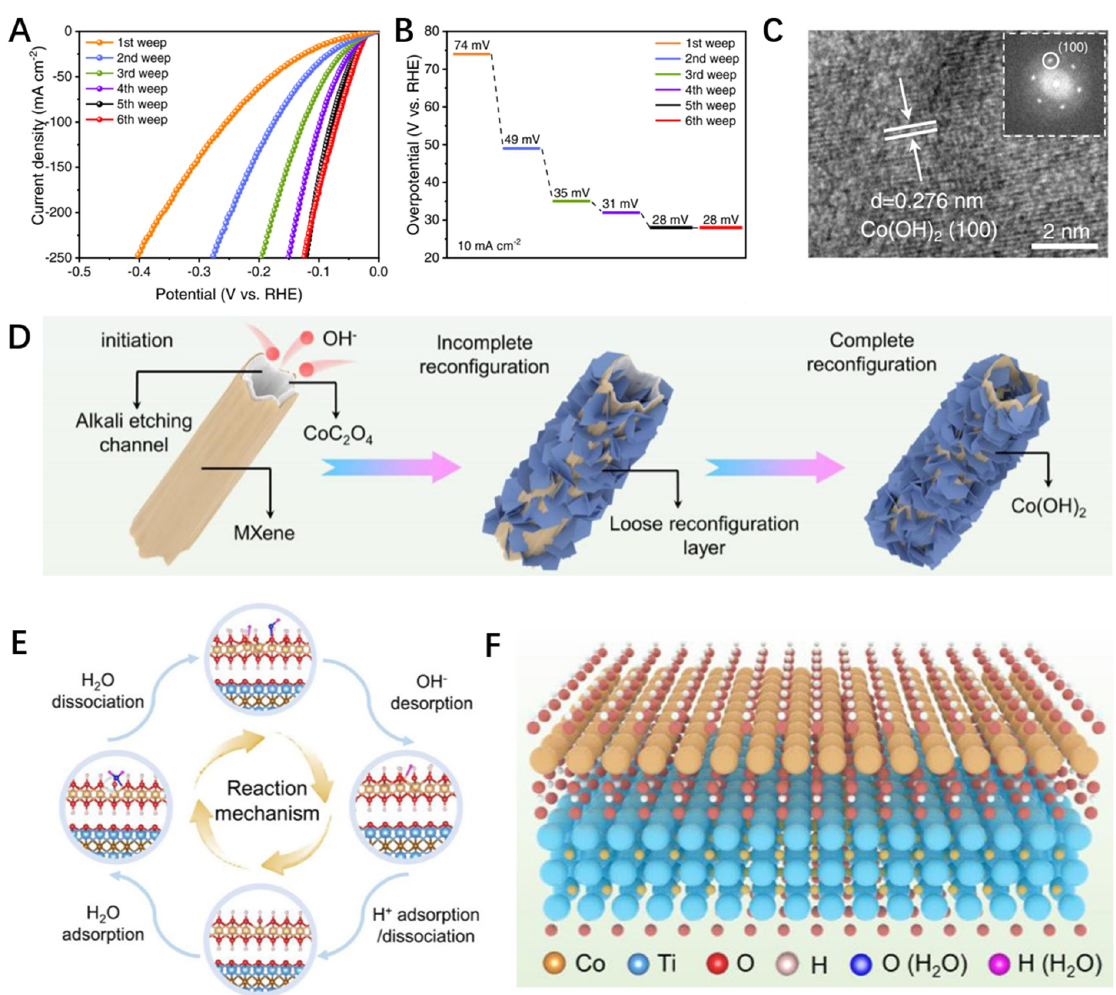
Figure 9. ( A ) Polarization curves of different LSV scans (IR correction) and ( B ) corresponding over- potentials of CoC 2 O 4 @MXene in a 1 M KOH solution. ( C ) HRTEM image of CoC 2 O 4 @MXene after the cycle. ( D ) Schematic diagram of the reconfiguration process of CoC 2 O 4 @MXene. ( E , F ) Schematic illustration of the catalytic mechanism of the alkaline HER on the CoC 2 O 4 @MXene after the cycle. Reproduced with permission from [60], ©Springer Nature 2017.